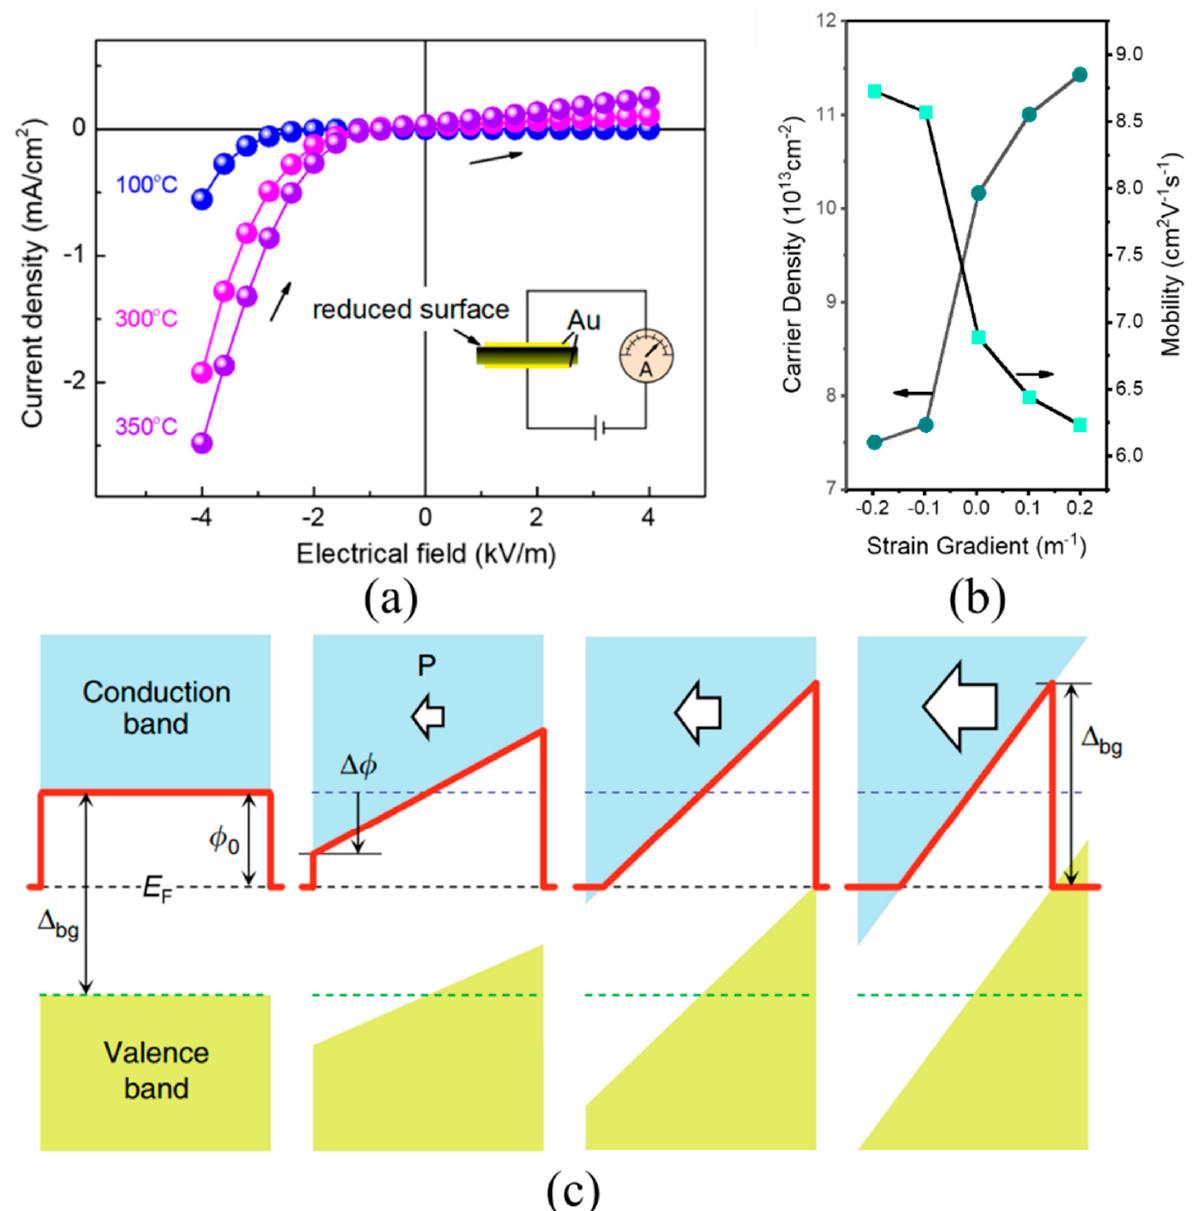
Figure 28. ( a ) The rectifying diode effect in asymmetrically reduced NBT-based ferroelectric ceramics because of the built-in electric field from the flexoelectric effect. Reprinted with permission from [107]. Copyright 2019 American Chemical Society. ( b ) The interface carrier densities and mobilities of 2DEG under different strain gradients for the LaAlO 3 /SrTiO 3 heterostructure. Reprinted with permission from [94]. Copyright 2019 American Physical Society. ( c ) Schematic diagram of the potential energy profiles with increasing flexoelectric polarization P (white arrow). The solid red and black dashed lines indicate the effective tunnel barrier and the Fermi level, respectively. The blue and green dashed lines indicate the conduction band minimum and valence band maximum for P = 0, respectively. Reprinted with permission from [89]. Copyright 2020 Springer Nature.